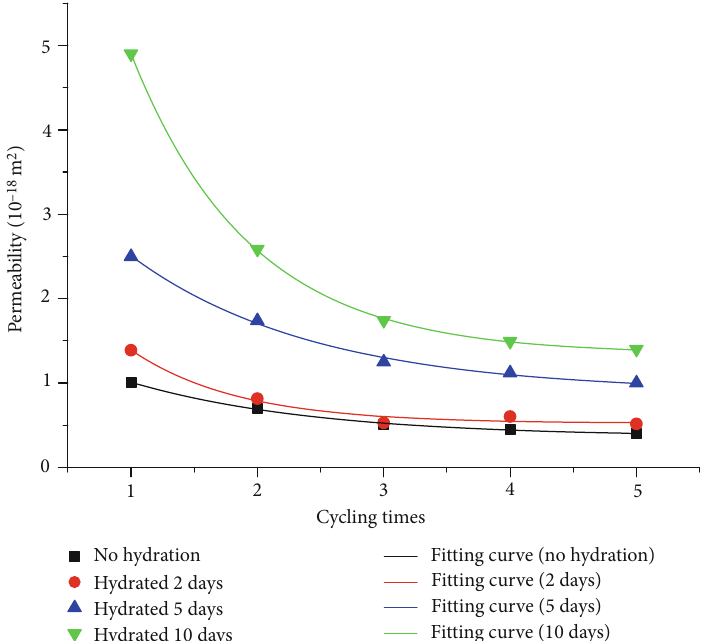
Figure 7: Comparison of permeability of hydrated shale under 5 cyclic loading and unloading